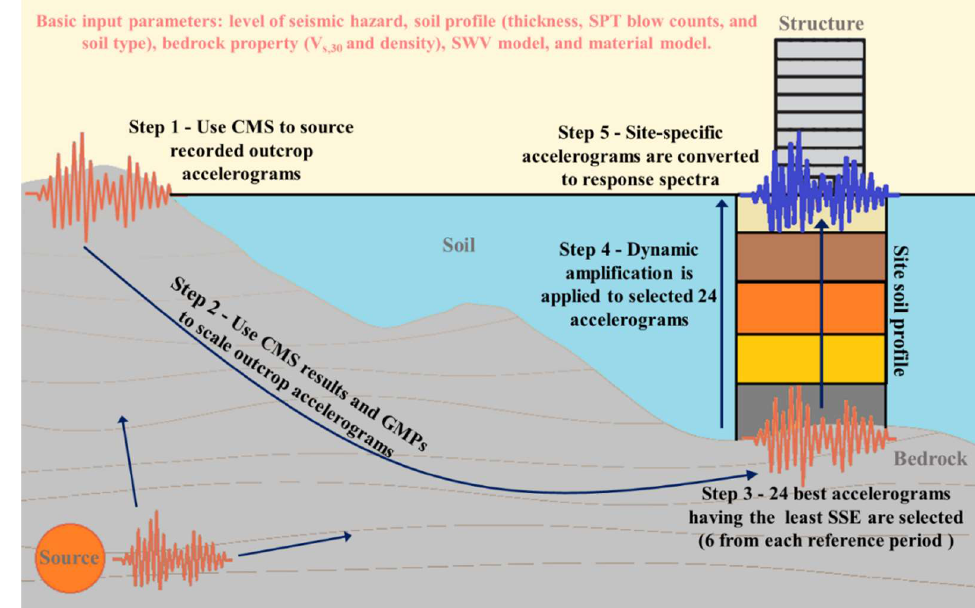
Figure 2. Procedures for generating site-specific response spectra. The orange and blue colour represents accelerograms at the bedrock (material in grey colour), and soil surface, respectively. The soil column profile obtained from the borehole is represented by layers of five different colours.